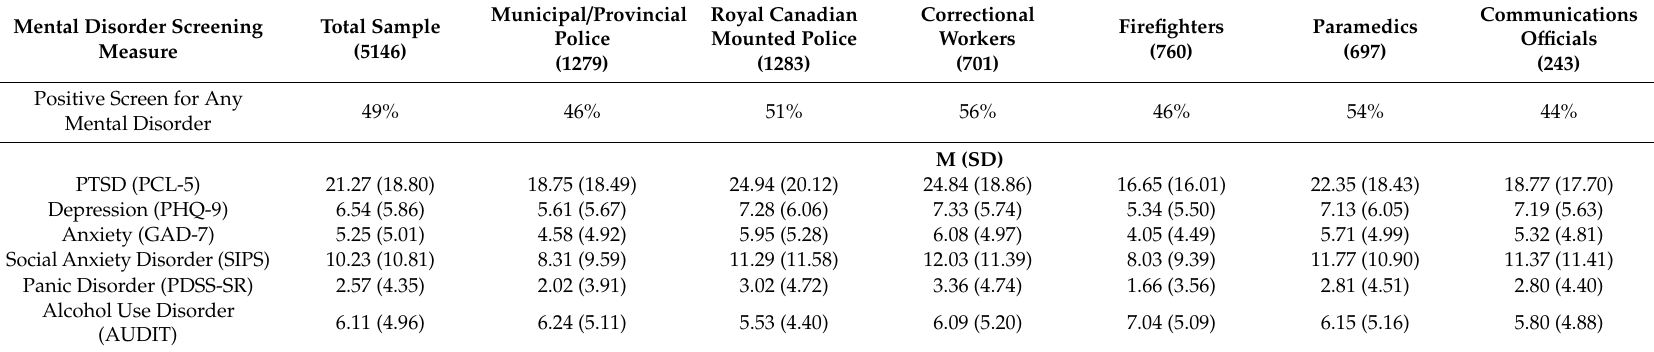
Table 3. Mean Scores on Mental Disorder Screening Measures and Frequency of Mental Disorder Positive Screen by Public Safety Personnel Category. Mental Disorder Screening